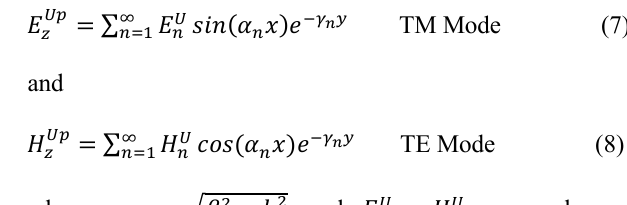
Fig.1. The geometry of 2-D IRTG filled with a material ε , µ # #